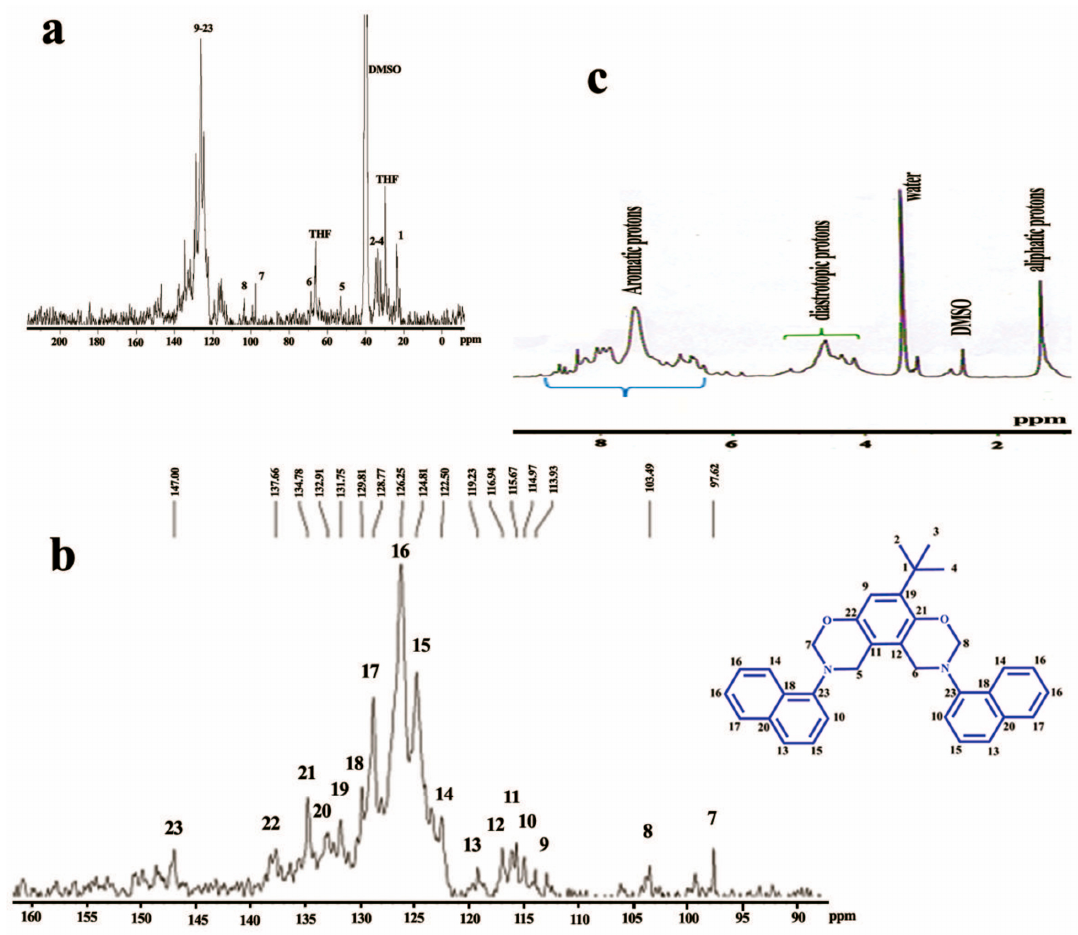
Figure 2. NMR spectra of monomer: ( a ) 13 C-NMR spectrum; ( b ) 13 C-NMR spectrum; ( c ) 1 H-NMR spectrum.